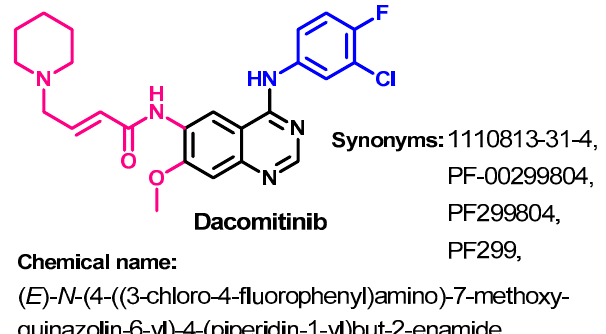
Figure 21. Chemical structure/name/synonyms of dacomitinib.